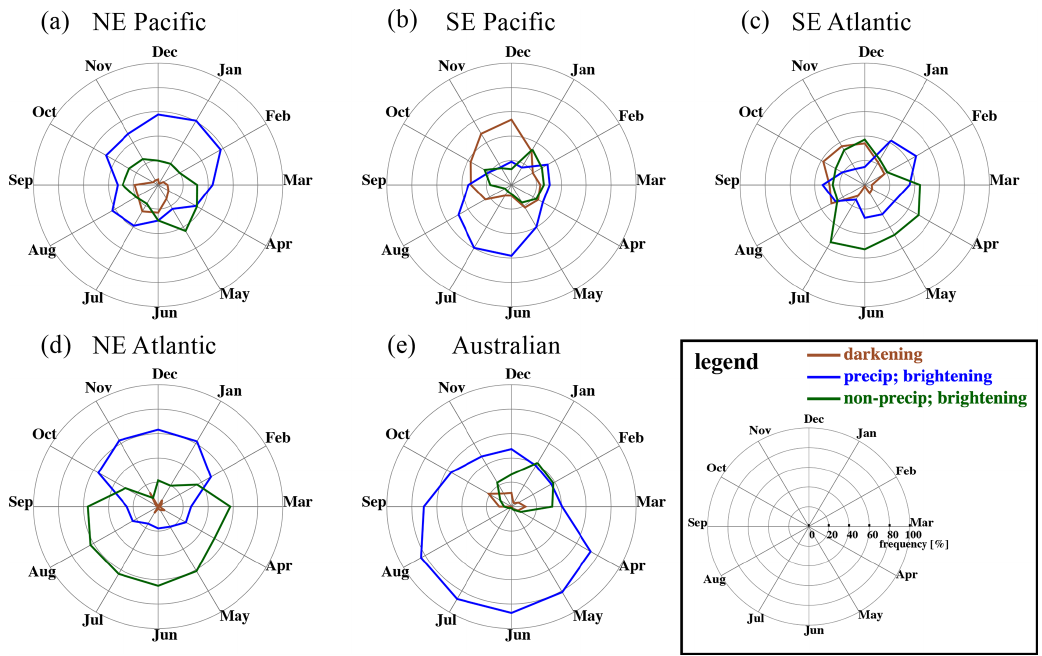
Figure 8. Monthly frequency of occurrence of the three susceptibility regimes: precipitating–brightening (blue), darkening (brown), and non- precipitating–brightening (green). Rows (a–e) represent results for the NE Pacific, SE Pacific, SE Atlantic, NE Atlantic, and the Australian stratocumulus regions,